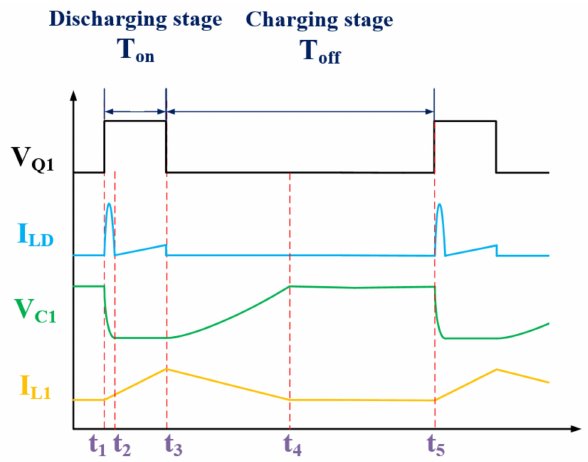
Figure 5. Timing diagram of circuit working process.